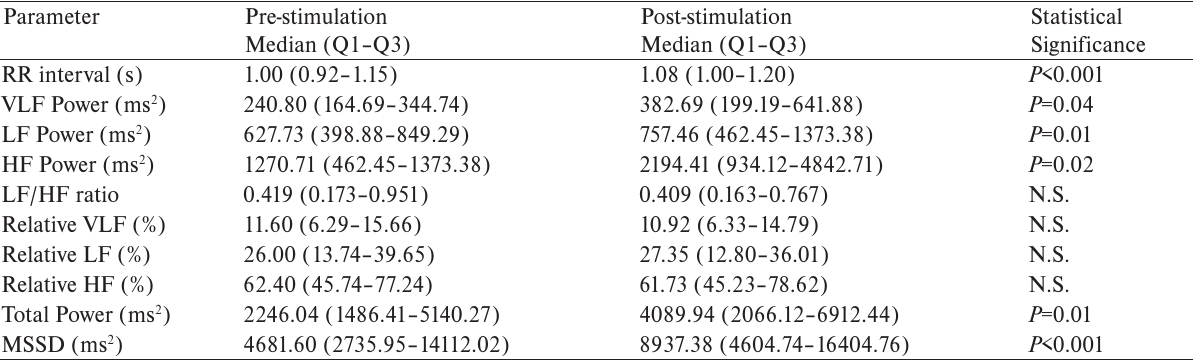
Table 1. Duration of RR intervals and parameters of heart rate variability: heel (active) stimulation site.